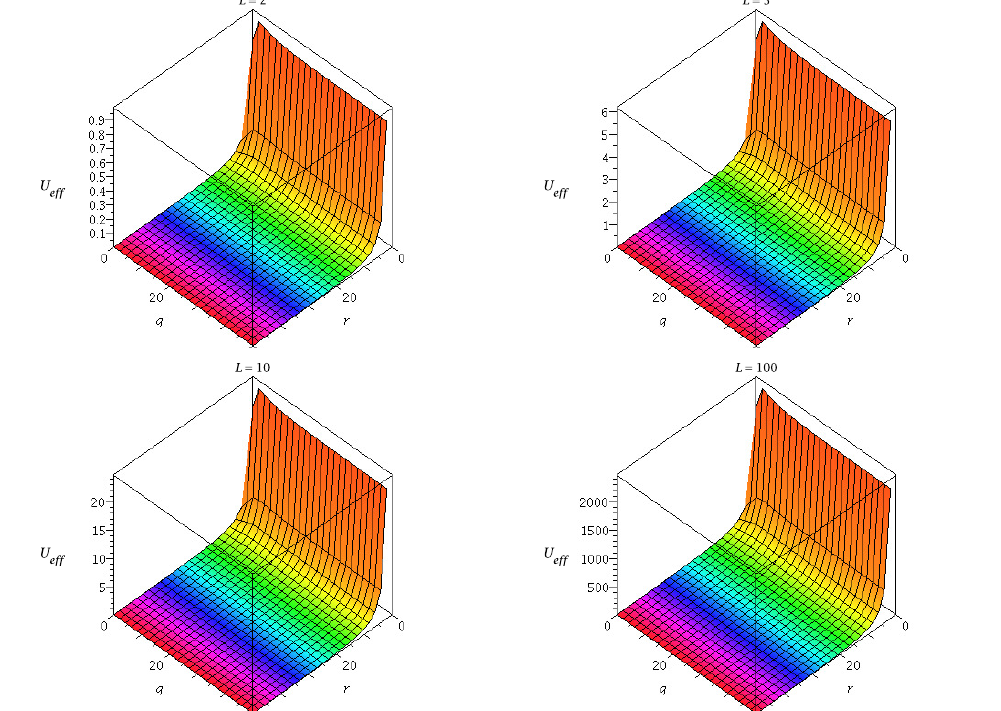
Figure 10. The figure depicts the variation of U ef f with r for ABG